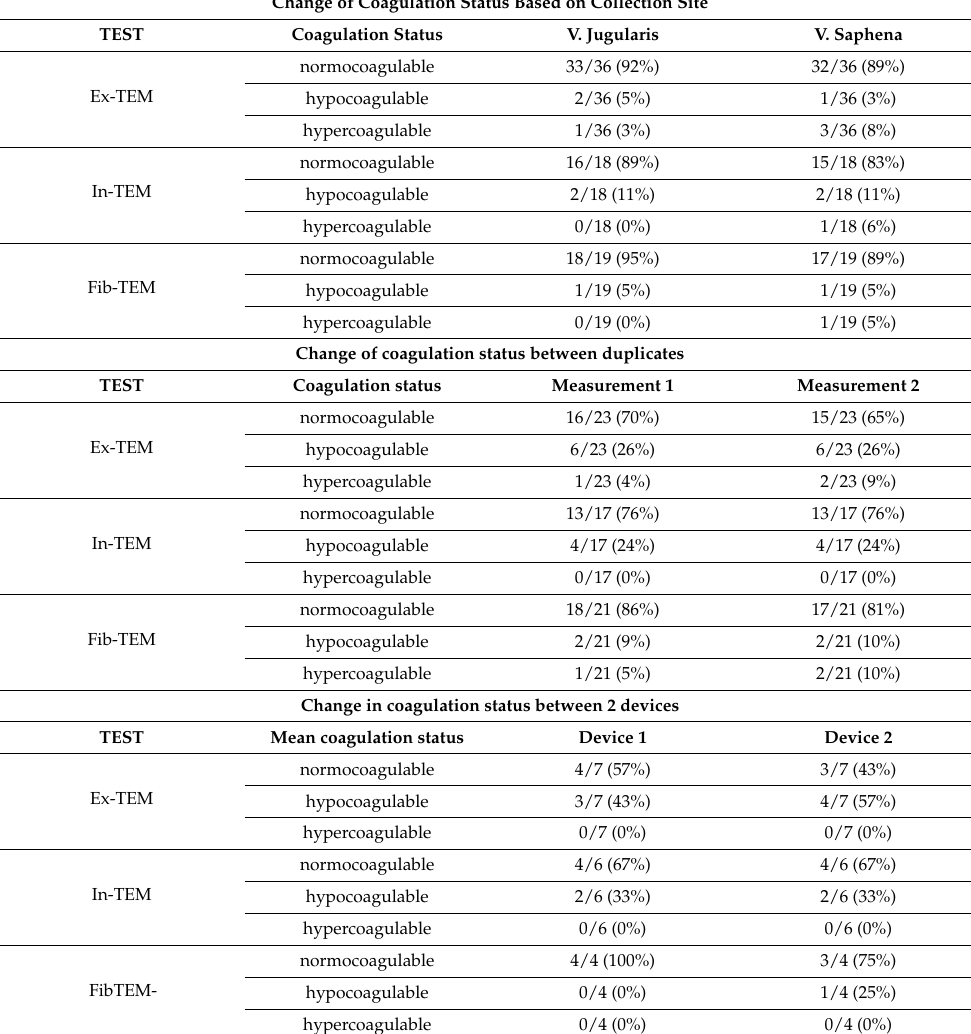
Table 2. Change of coagulation status with samples measured simultaneously from 2 different sampling sites (jugular vs. saphenous), as duplicates and on 2 different